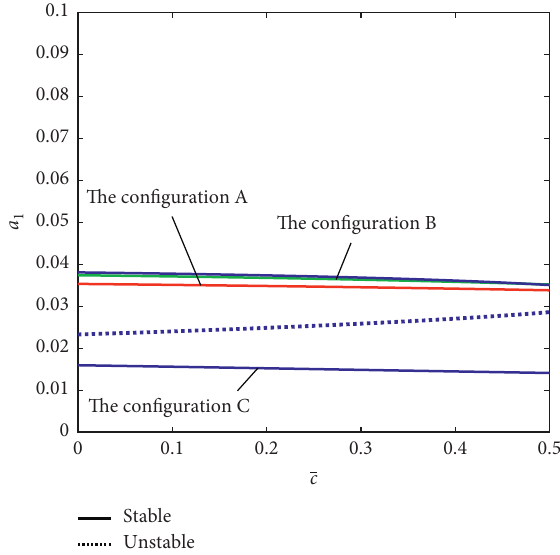
Figure 24: Amplitude versus cutting force coefficient with different rotating speeds ( σ � 2, c � 0.01, θ � 0 ° ,L/d � 10, case I).